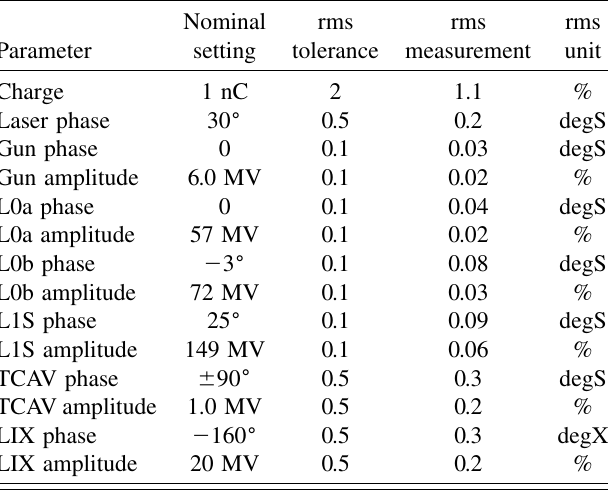
TABLE III. Charge, rf phases (with respect to crest), and amplitudes, showing nominal settings, rms short-term stability tolerances, and achieved rms values for the LCLS injector. The measured values are an rms over 20 seconds at a 10-Hz sample rate.